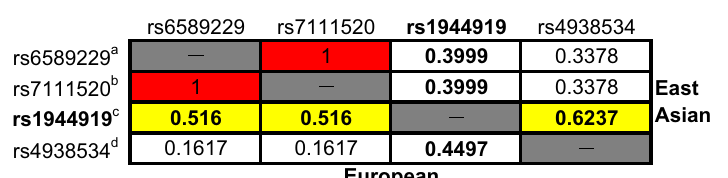
Table 2. Linkage disequilibrium (r 2 ) among important SNPs in chromosome 11q23.1. a Top-hit SNPs in a GWAS for Eosinophil count in the European descent. b Top-hit SNPs in a GWAS for Hodgkin’s lymphoma in the European descent. c Primary functional variant in the present study. d Top-hit SNPs in a GWAS for PBC in the Japanese population.